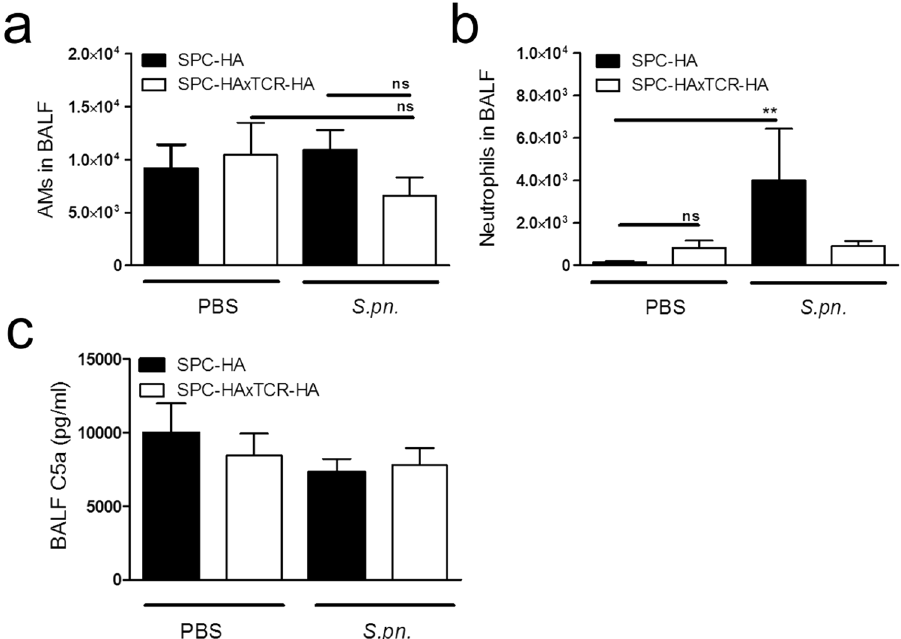
Figure 5. Improved bacterial clearance is not associated with increased AM numbers nor with increased intra-pulmonary neutrophil recruitment in SPC-HAxTCR-HA mice. Mice were oropharyngeally inoculated with ~1.5 × 10 4 CFU S . pneumoniae TIGR4 or were mock-treated (PBS). At 24 h p.i. mice were sacrificed and phagocytic leukocyte subsets in the BALF ( a , b ) were quantified by flow cytometry. ( c ) BALF supernatants were anylyzed by ELISA for levels of complement component C5a. Data were pooled from at least 2 independent experiments (n = 5–8/group). ** p <